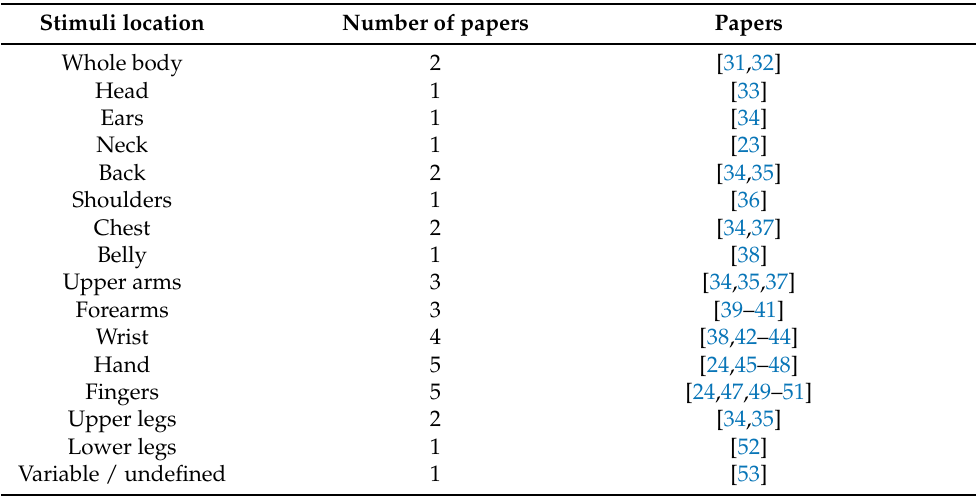
Table 3. Body parts that receive the haptic